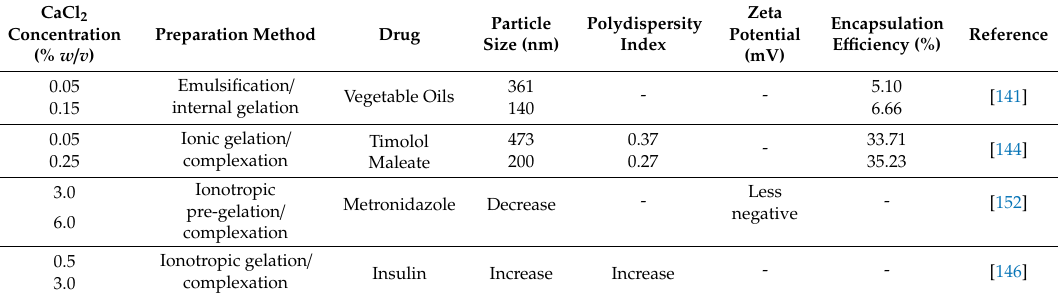
Table 5. The influence of CaCl 2 concentration on alginate